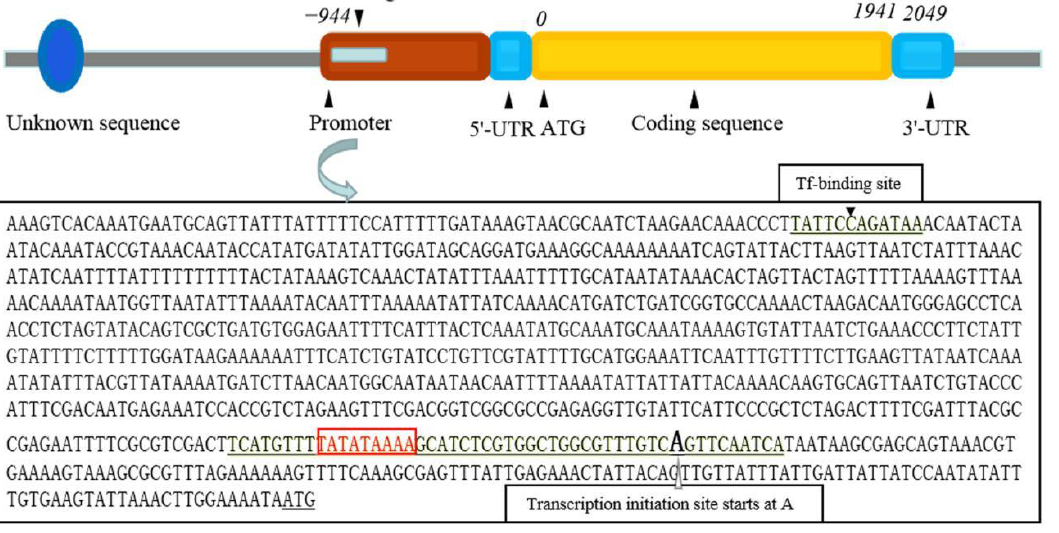
Figure 1. Schematic representation of the promoter sequence of the AhHsp70 gene ( AhHsp70 p) from Agasicles hygrophila based on bioinformatics analysis. The AhHsp70 p sequence contains multiple functional elements and a common TATA box at approximately 30 bp upstream of the transcription start site. Transcription is believed to commence at a purine base approximately 137 bp upstream of the coding region of ATG. The blue circle on the left represents other unknown sequences upstream of the AhHsp70 p. −944, 0, 1941, and 2049 refer to the cloned promoter sequence location, the start codon location, the end of the coding region sequence location, and the 3′ -UTR sequence location, respectively.